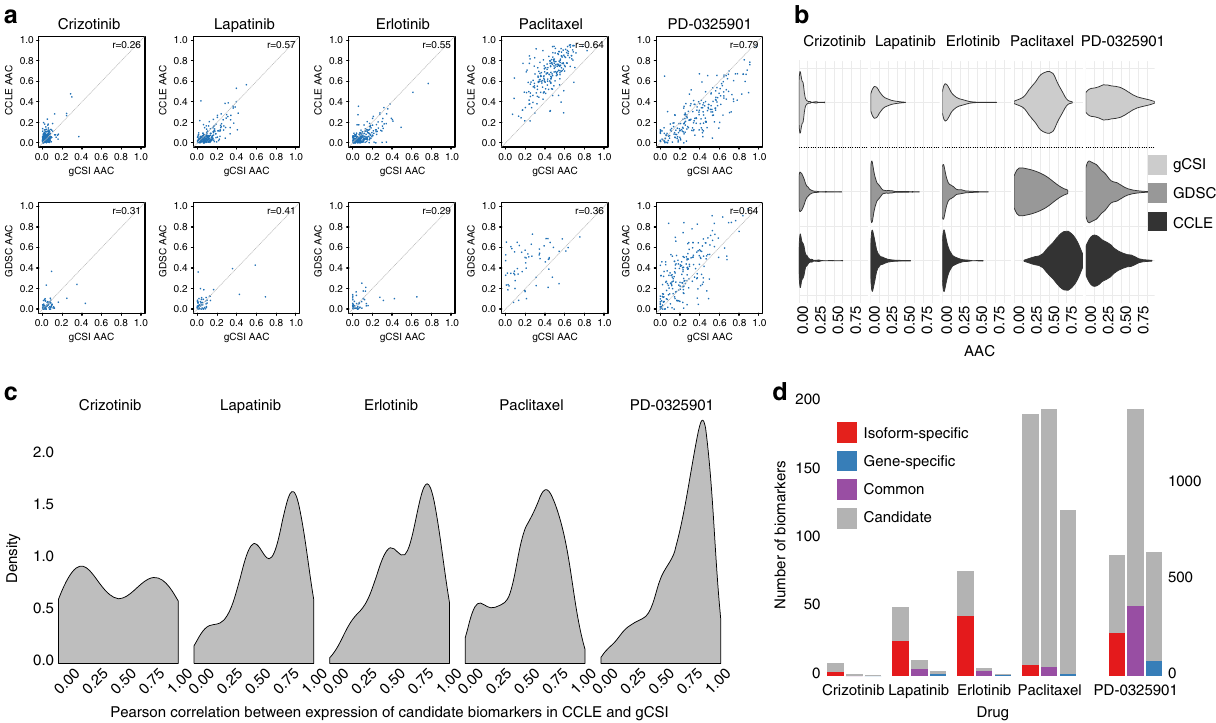
Fig. 4 Pan-cancer validation of candidate biomarkers. Consistency between the training sets (CCLE and GDSC) and the validation set (gCSI) at the level of a , b drug sensitivity and c isoform and gene expression values. a The area above the drug response curve (AAC) values between the two training datasets and gCSI are plotted with their correlations for the common drugs. b The distributions of the AAC values compared for each and dataset. c The distribution of Pearson correlations for candidate biomarker expressions between CCLE and gCSI plotted for each common drug. d The number of candidate and pre- validated biomarkers plotted for each